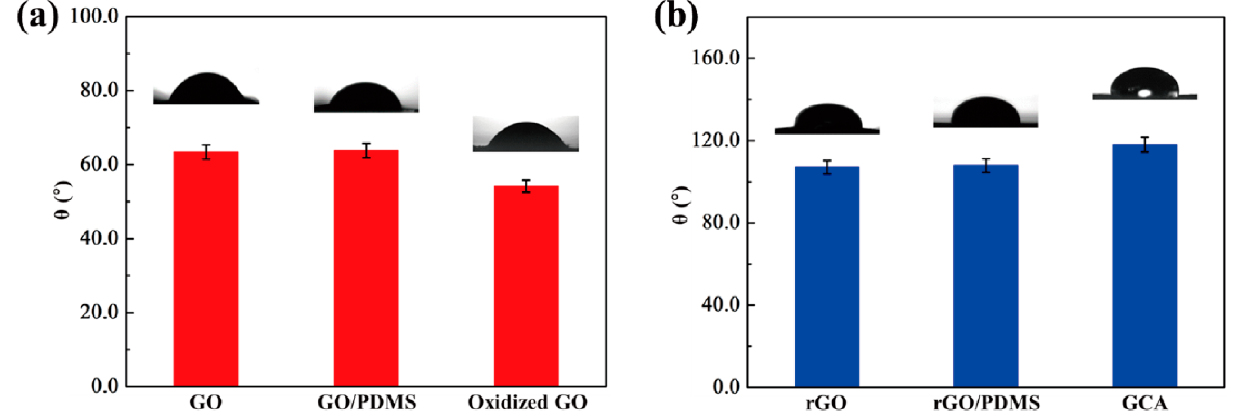
Figure 2. Contact angles of ( a ) GO, GO/PDMS, and oxidized GO, ( b ) rGO, rGO/PDMS, and GCA.